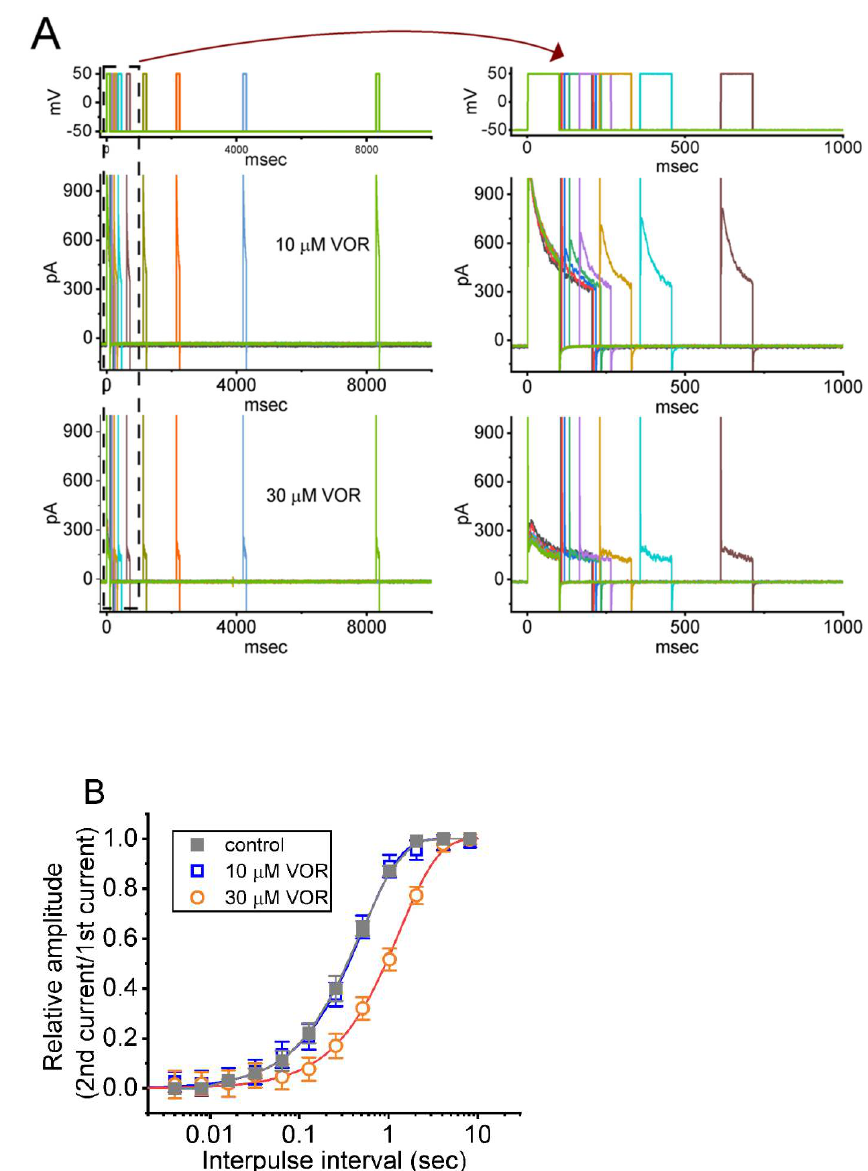
Figure 6. The time course of the recovery of I K(DR) inactivation in the presence of 10 and 30 µ M VOR. In these experiments, cells, bathed in Ca 2+ -free Tyrode’s solution, were depolarized from − 50 to +50 mV with a duration of 100 ms, and varying interpulse durations with a geometric progression were applied to the tested cells. ( A ) Representative current traces obtained in the presence of 10 µ M VOR (upper) and 30 µ M VOR (lower). The uppermost parts denote the voltage-clamp protocol applied. The right side in ( A ) shows the expanded records (i.e., potential and current traces) taken from the dashed box in the left side for a short time scale. ( B ) The mean relationship of the relative amplitude versus the interpulse interval in the absence (filled gray squares) and presence of 10 mM VOR (open blue squares) or 30 µ M VOR (open red circles). The x-axis is displayed on the logarithmic scale. The time course as indicated in smooth line was goodness-of-fit to a single exponential. Each point represents the mean ± SEM (n =